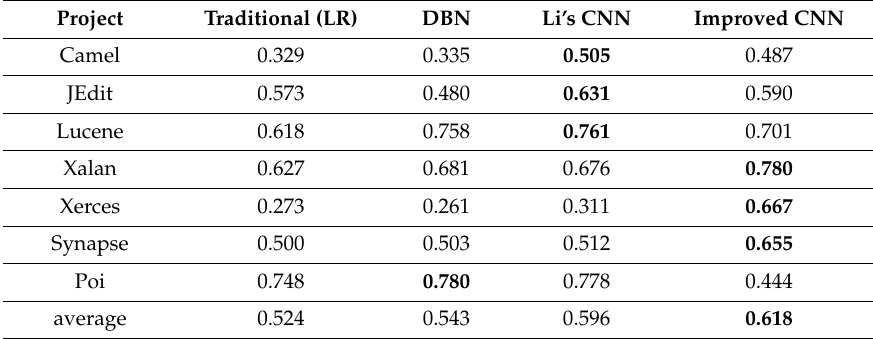
Table 4. Performance comparison of di ff erent models on the SPSC dataset. The decimal values represent the average F-measure values. The best F-measure values are highlighted in bold.